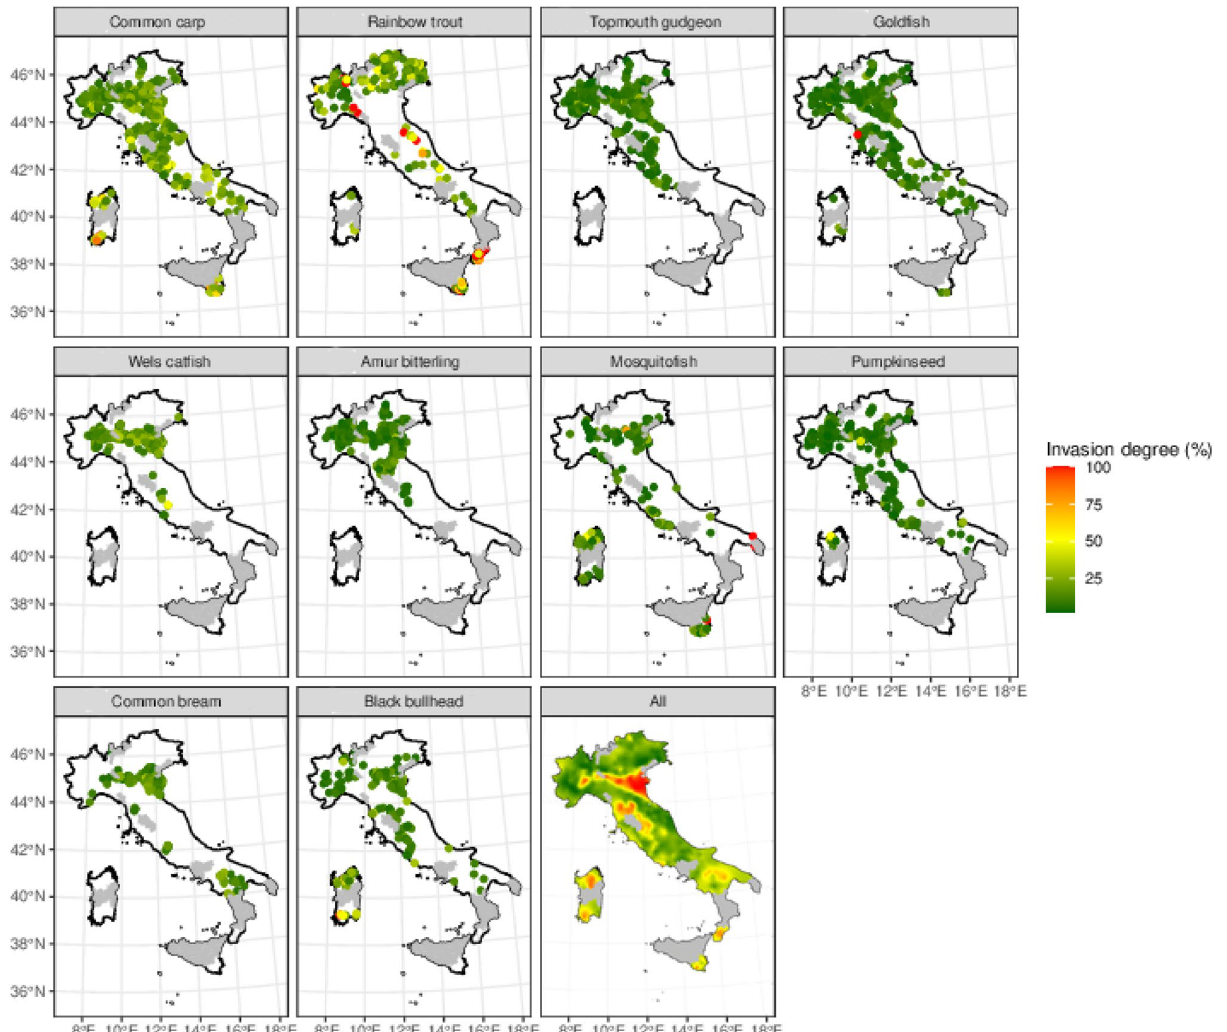
Figure 1. Spatial distribution of the overall invasion degree (all exotic species, last panel), and its top 10 species components (other panels, in order of invasiveness rank left to right and top to bottom), the main response variable in this study. This figure was created with R 31